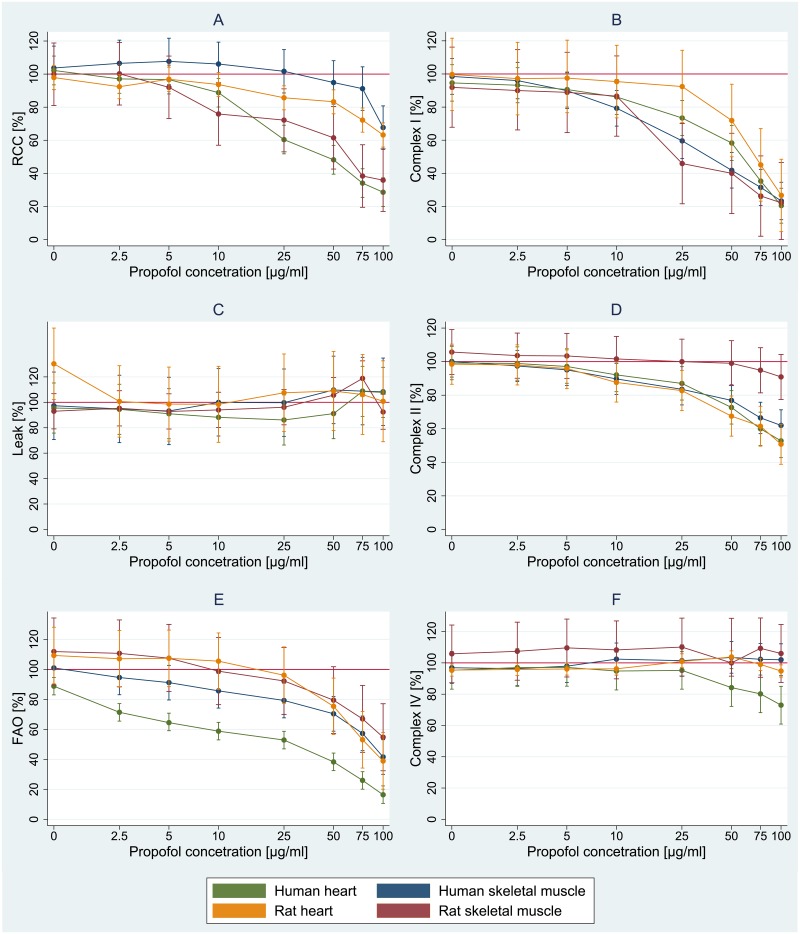
Prediction of difference of respiratory parameters against control at different concentration of propofol.Graph A–respiration chain capacity, graph B–complex I, graph C–LEAK, graph D—complex II, graph E–FAO, graph F–complex IV.